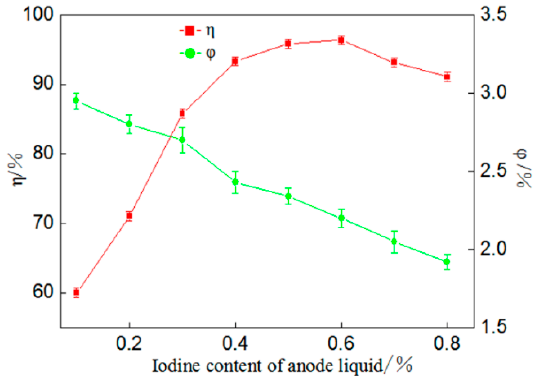
Figure 2. Influence of mass fraction of iodine in anolyte on percentage of gold deposition ( η ) and coulombic efficiency ( φ ).